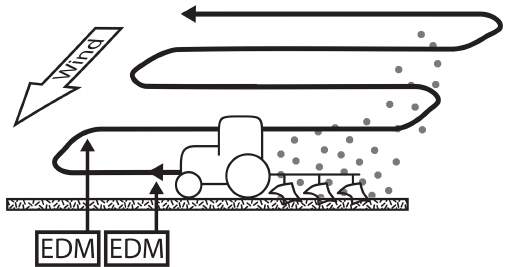
Figure 2. Sketch of the experimental set-up: the tractor drives in parallel orientated tracks over the field. Downwind the emitted par- ticle plume is measured by two vertically stacked Environmental Dust